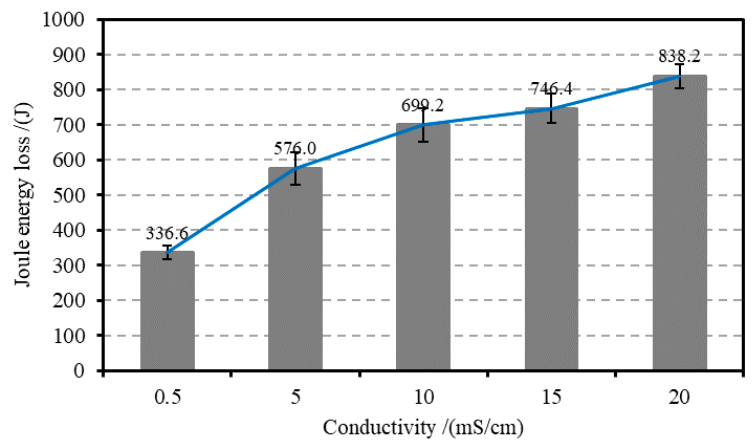
Figure 8. Joule energy loss under different electrical conductivity.